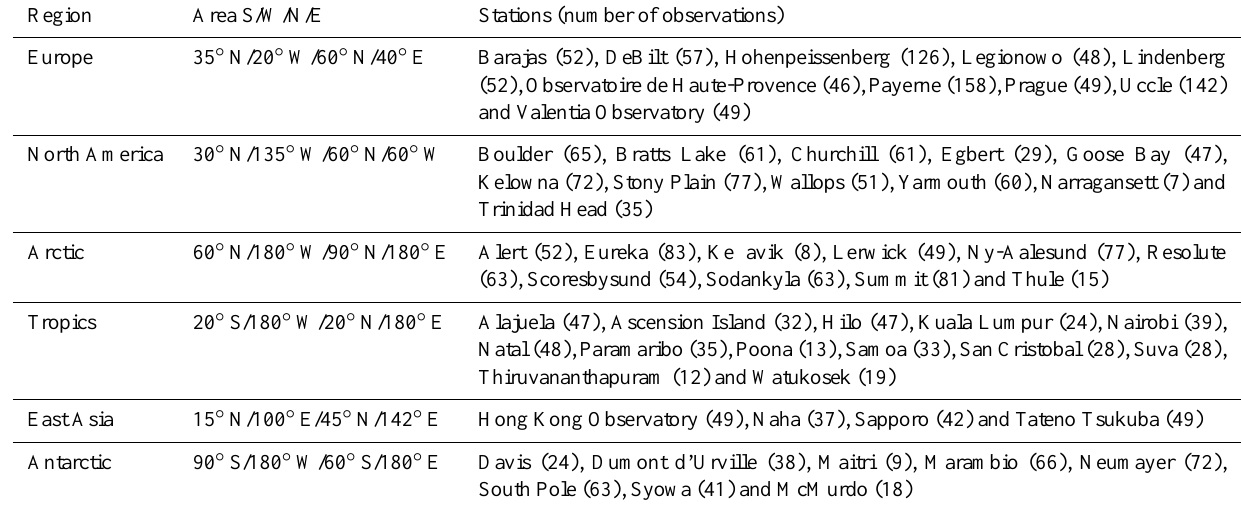
Table 2. Ozonesonde sites used in the evaluation for different regions. Region Area S/W/N/E Stations (number of observations) Europe 35 ◦ N/20 ◦ W/60 ◦ N/40 ◦ E Barajas (52), DeBilt (57), Hohenpeissenberg (126), Legionowo (48), Lindenberg (52), Observatoire de Haute-Provence (46), Payerne (158), Prague (49), Uccle (142) and Valentia Observatory (49) North America 30 ◦ N/135 ◦ W/60 ◦ N/60 ◦ W Boulder (65), Bratts Lake (61), Churchill (61), Egbert (29), Goose Bay (47), Kelowna (72), Stony Plain (77), Wallops (51), Yarmouth (60), Narragansett (7) and Trinidad Head (35) Arctic 60 ◦ N/180 ◦ W/90 ◦ N/180 ◦ E Alert (52), Eureka (83), Keflavik (8), Lerwick (49), Ny-Aalesund (77), Resolute (63), Scoresbysund (54), Sodankyla (63), Summit (81) and Thule (15) Tropics 20 ◦ S/180 ◦ W/20 ◦ N/180 ◦ E Alajuela (47), Ascension Island (32), Hilo (47), Kuala Lumpur (24), Nairobi (39), Natal (48), Paramaribo (35), Poona (13), Samoa (33), San Cristobal (28), Suva (28), Thiruvananthapuram (12) and Watukosek (19) East Asia 15 ◦ N/100 ◦ E/45 ◦ N/142 ◦ E Hong Kong Observatory (49), Naha (37), Sapporo (42) and Tateno Tsukuba (49) Antarctic 90 ◦ S/180 ◦ W/60 ◦ S/180 ◦ E Davis (24), Dumont d’Urville (38), Maitri (9), Marambio (66), Neumayer (72), South Pole (63), Syowa (41) and McMurdo